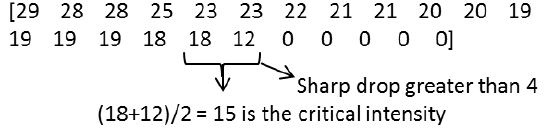
Figure 6. Median intensity values calculated for the